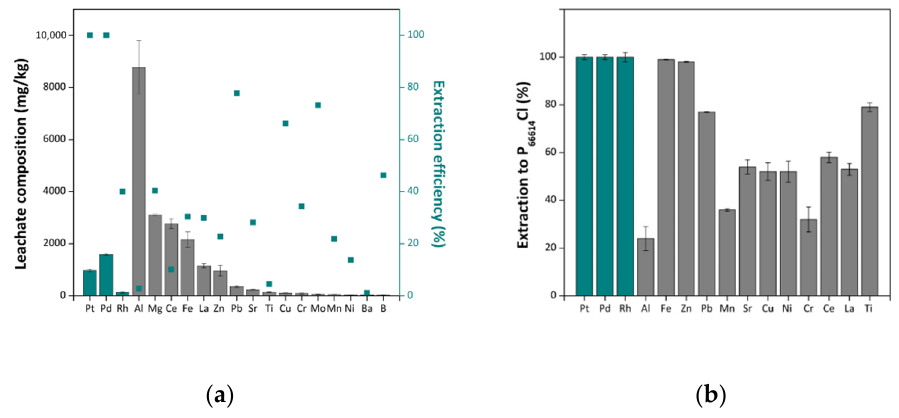
Figure 6. Concentration (mg/kg) of elements and respective extraction efficiencies to the DES phase ( a ) and extraction efficiencies of elements to the phosphonium IL P 66614 Cl phase ( b ).